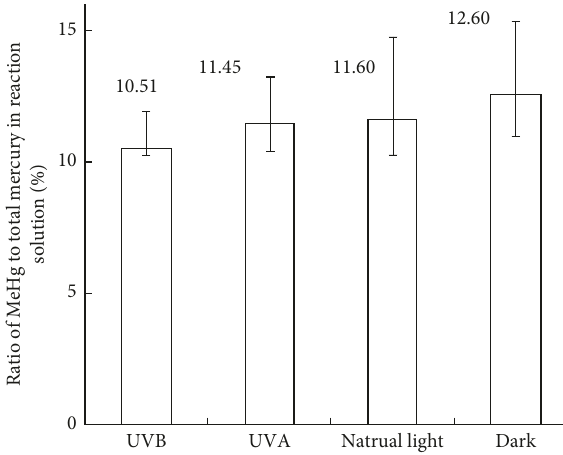
Figure 2: Ratio of MeHg to total mercury in reaction solution at the end of the